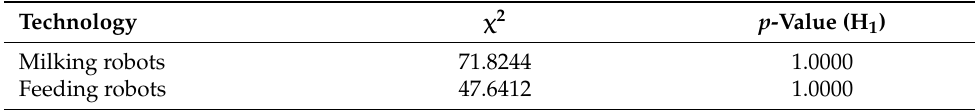
Table 4. The results of statistical evaluation for robots in livestock